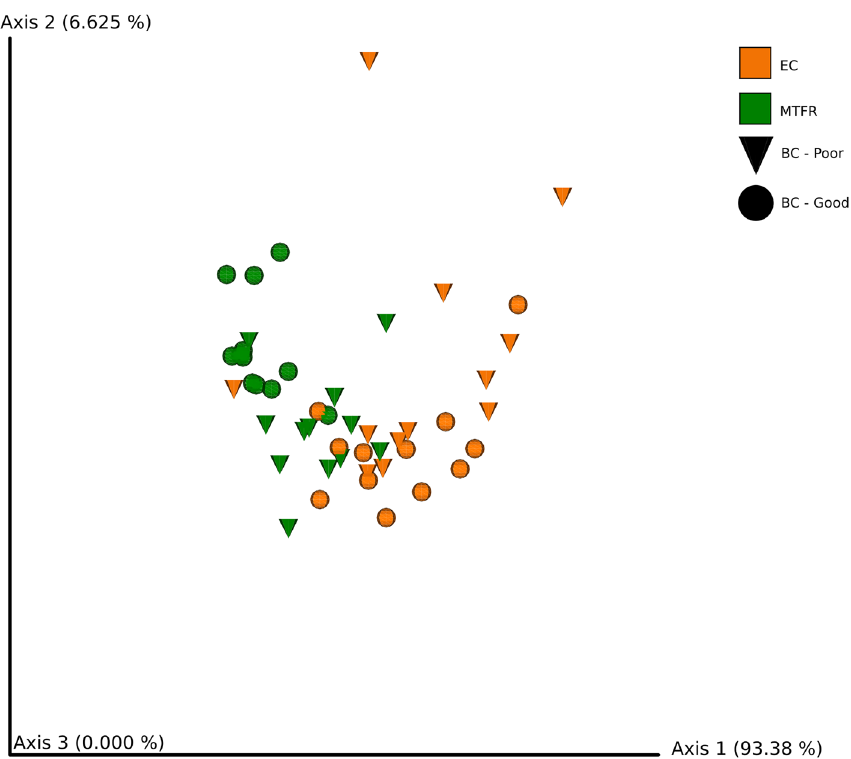
Figure 7. PCoA plot showing robust Aitchison distance between samples from enriched cage (EC, orange) and multi-tier free range (MTFR, green) chickens with poor (triangle) and good (circle) body condition. There is clustering of samples by housing system, with some subdivision by body condition